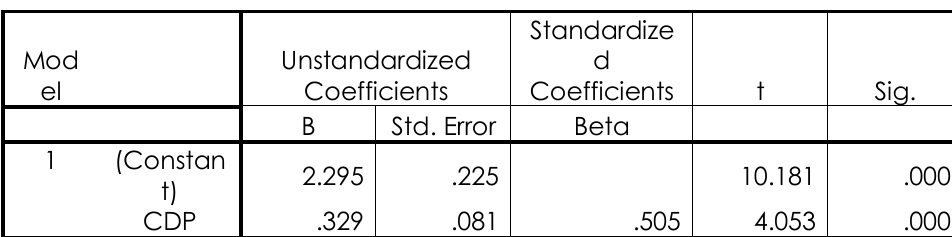
Tabel 2. Koefisien Regresi Secara